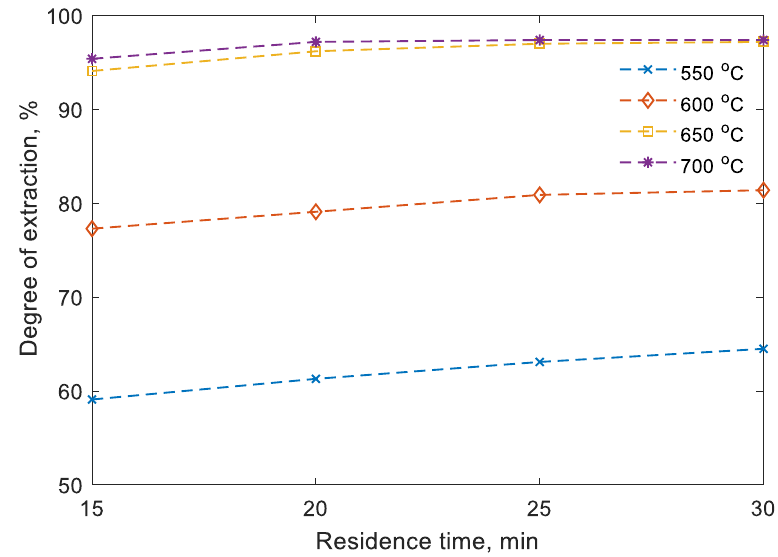
Figure 3. Dependence of the degree of extraction of neodymium and the residence time at temperatures of 550–700 °C.